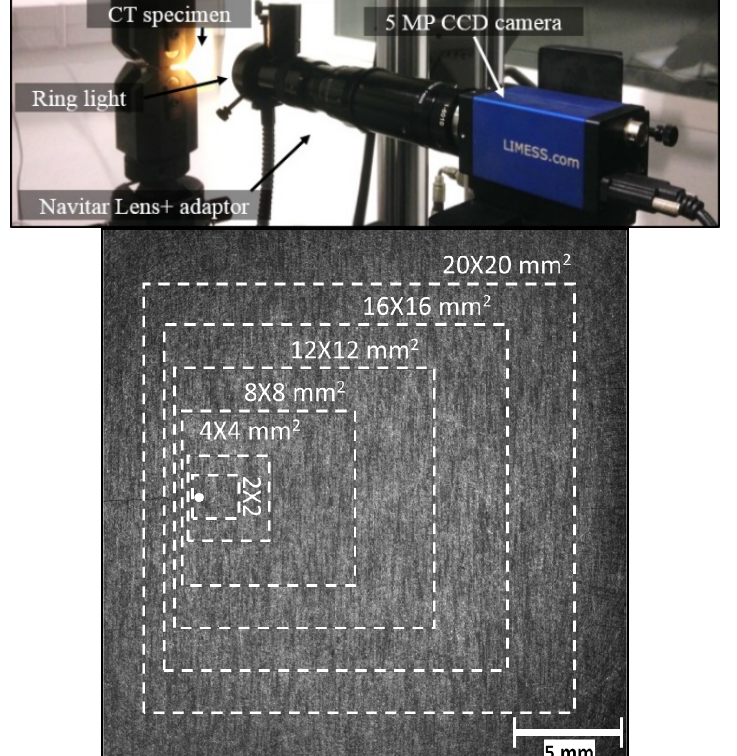
Figure 2.Imaging set up and selected AOIs for a constant field of view. The white point highlights the crack tip